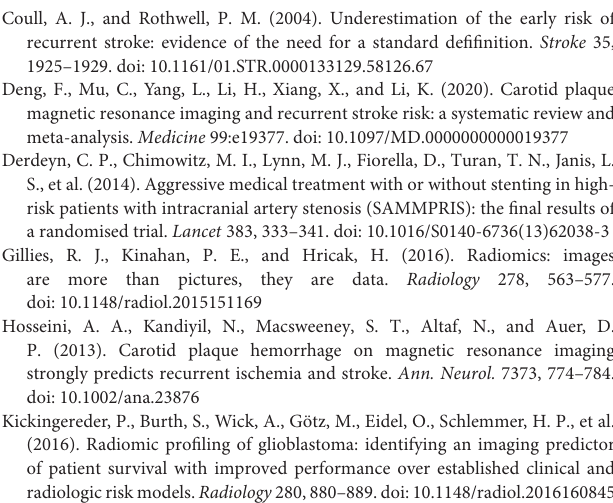
Supplementary Figure 1 | Flow chart of the study eligible patients. Supplementary Figure 2 | Plaque outline presentation. T2WI shows MCA atherosclerotic plaque of M1 segment of right middle cerebral artery (A) . Plaque were drawn layer by layer on the T2WI-TSE images (B) . The volume of the lesion was sketched along the boundary of the plaque to generate the 3D volume of interest (VOI) (C) . Supplementary Figure 3 | An example of using the nomogram to illustrate the individual risk of stroke recurrence in SICAS. A 38-years-old male was showed paroxysmal dysphasia with right limb weakness for 1 week. MRA demonstrates stenosis and plaque of M1 segment of left middle cerebral artery, the plaque burden was 0.83 ( A,B , yellow line). The enhancement ratio of plaque was 3.3 ( C,D , blue line). No diabetes history (purple line), Rad_score (green line). The values on the Points scale intersected by the lines were added to obtain total points (28 + 16 + 0 + 62 = 106). The total points > 82 points, considered as a high-risk patient. The graph revealed that the risk of stroke recurrence in SICAS was over 82% by drawing a vertical line on the Total points scale. Cerebral infarction recurred in the distribution of the left middle cerebral artery after followed up for 6